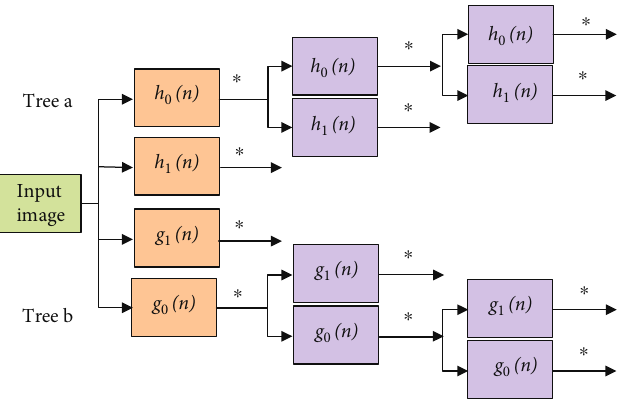
Figure 3: Schematic diagram of the decomposition process of the one-dimensional DTCWT method. Real part